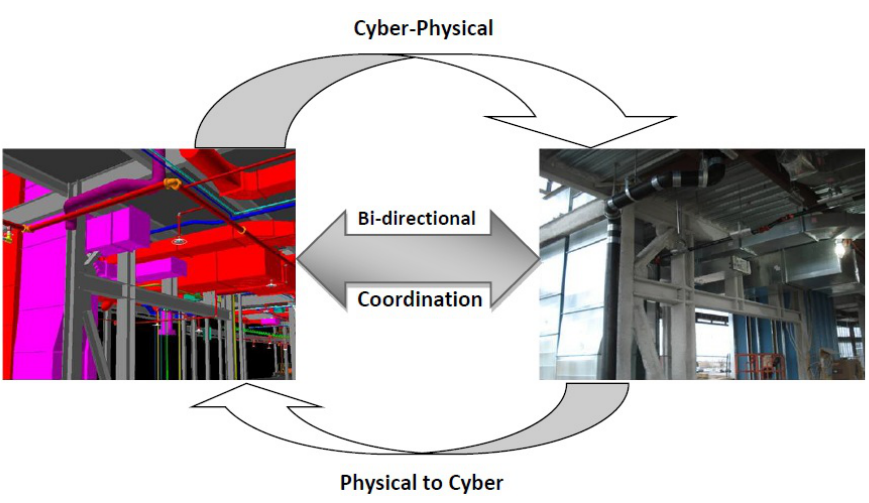
Fig. 4. Two-way Integration of Cyber-Physical Systems (Source: A. Akanmu